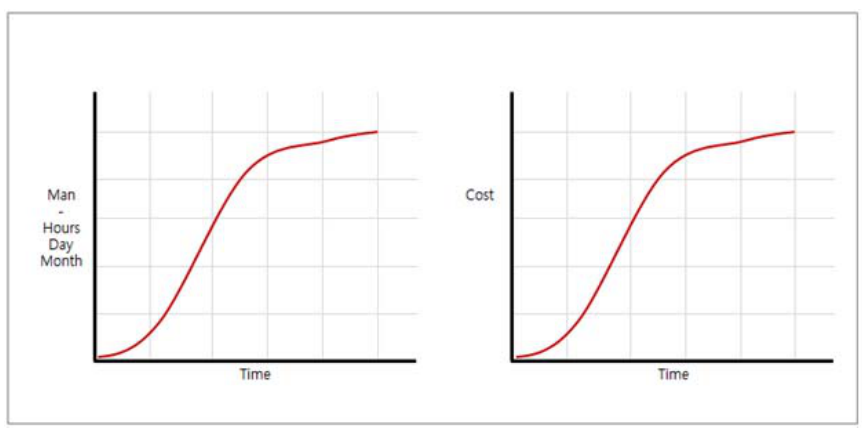
Figure 4. A type of S ‐ curve.